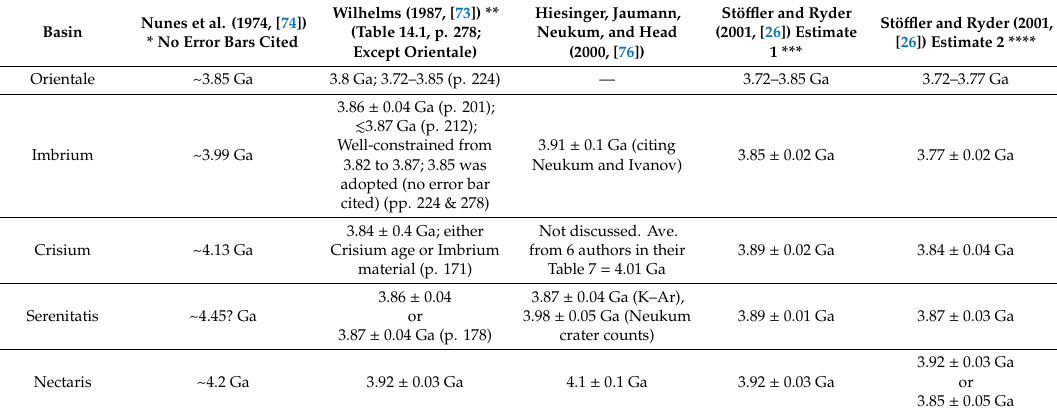
Table 1. Examples of radiometric-based estimates of lunar multi-ring basin ages 1974–2001. Basin